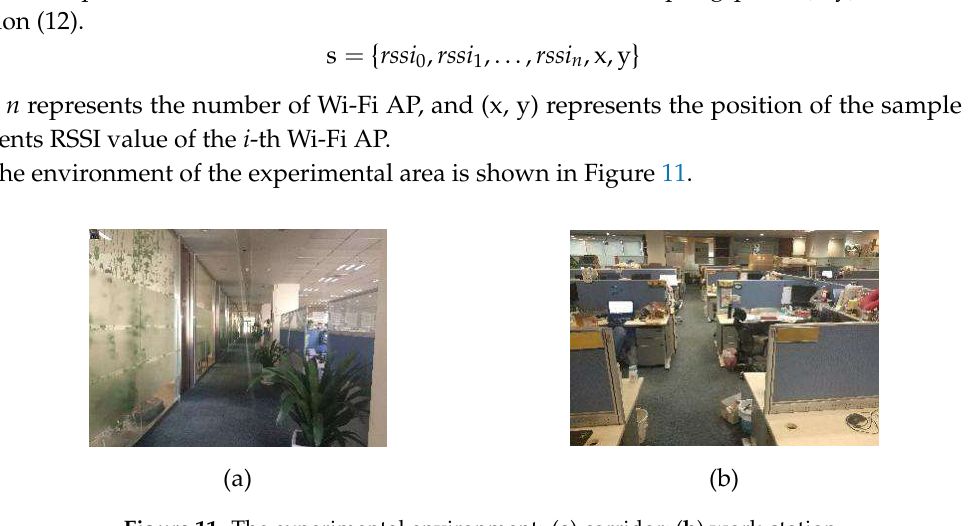
Figure 10. The sample position of the Dataset3 in our laboratory.